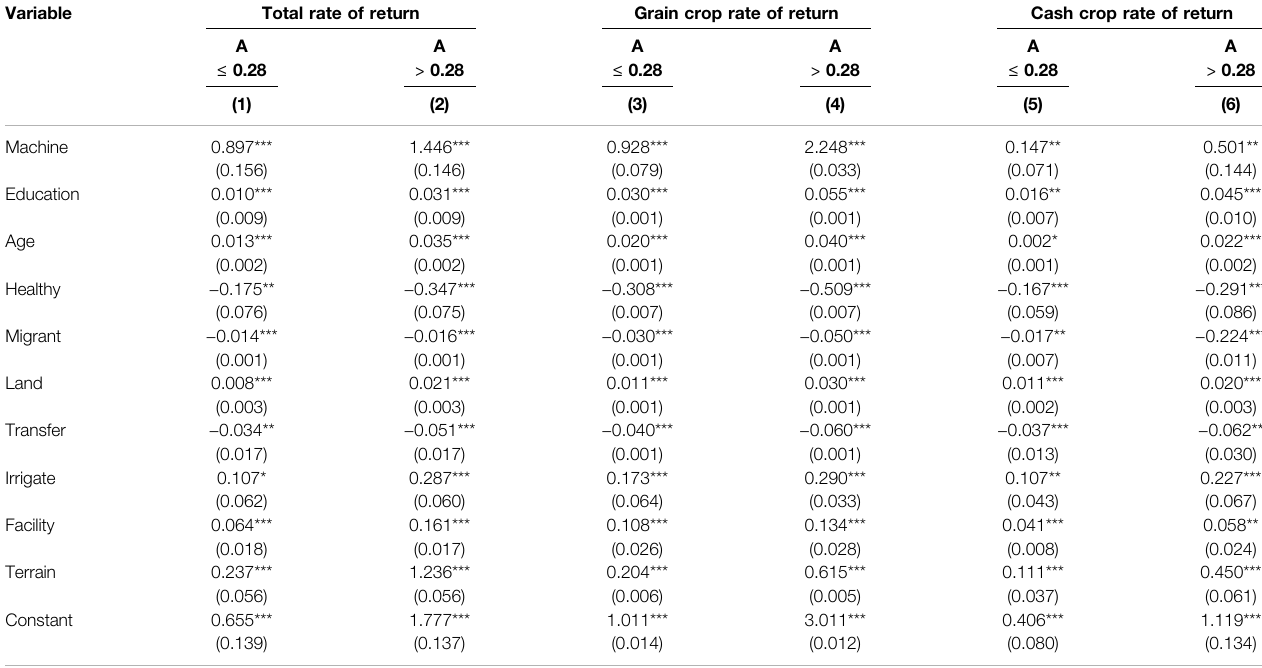
TABLE 8 | Estimation of the threshold effect of agricultural mechanization level on the rate of return.